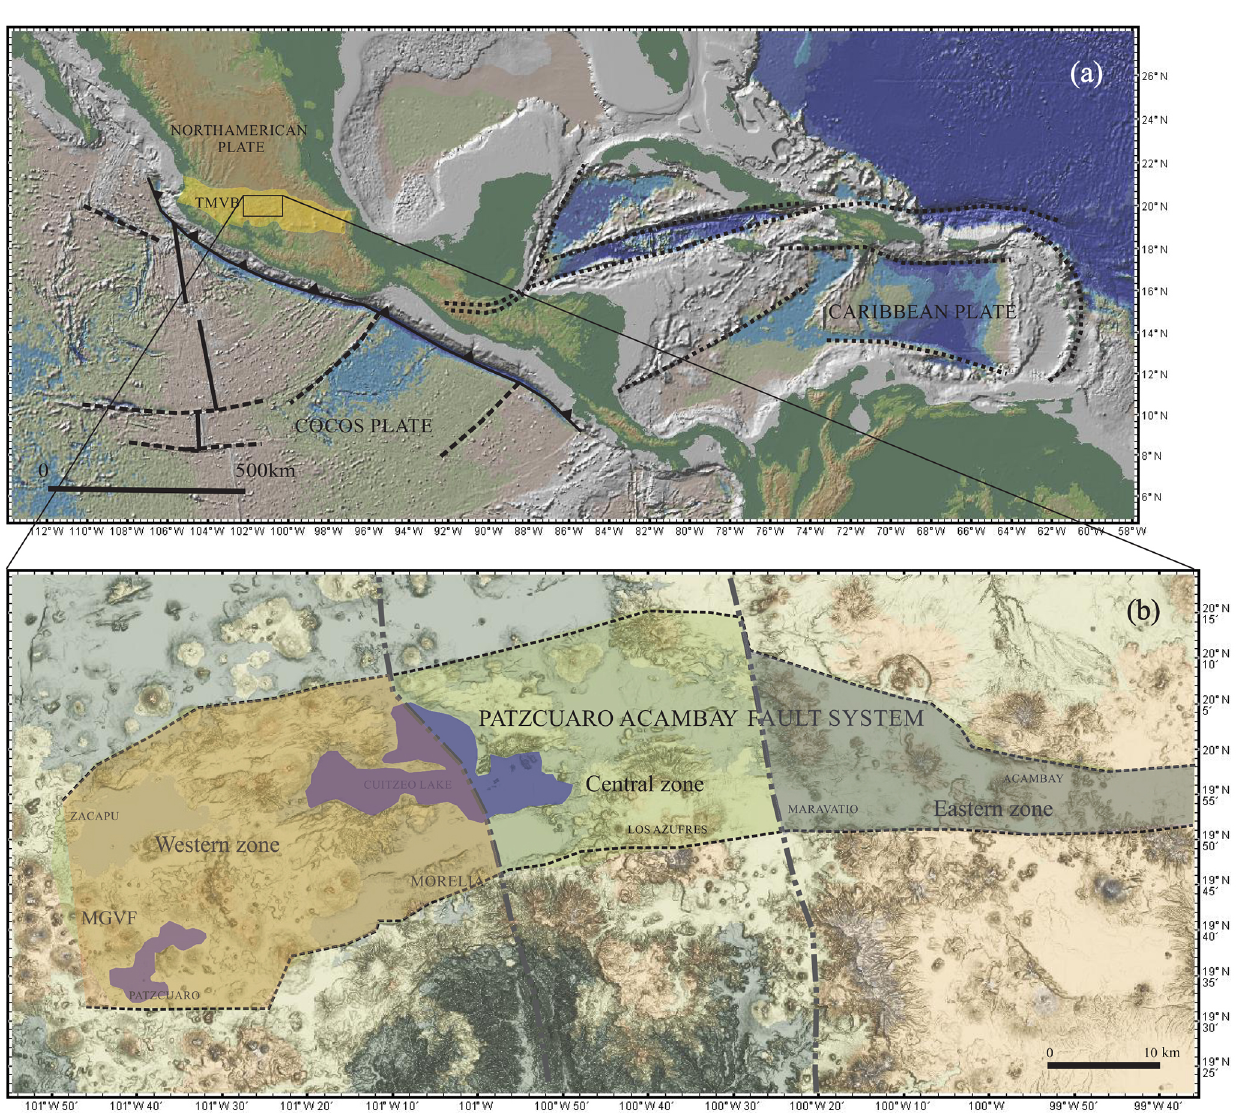
Figure 1. (a) Tectonics and geodynamic setting of the Trans-Mexican Volcanic Belt (yellow area). Dotted black lines are plate boundaries and the continuous black line is the Middle America Trench. The Pátzcuaro–Acambay fault system (PAFS) is outlined by the black rectangle. TMVB: Trans-Mexican Volcanic Belt. (b) Tectonic area of the Pátzcuaro–Acambay fault system that shows the limits (thick dashed gray lines) between the three zones of the PAFS (western, central, and eastern zones). MGVF: Michoacán–Guanajuato Volcanic